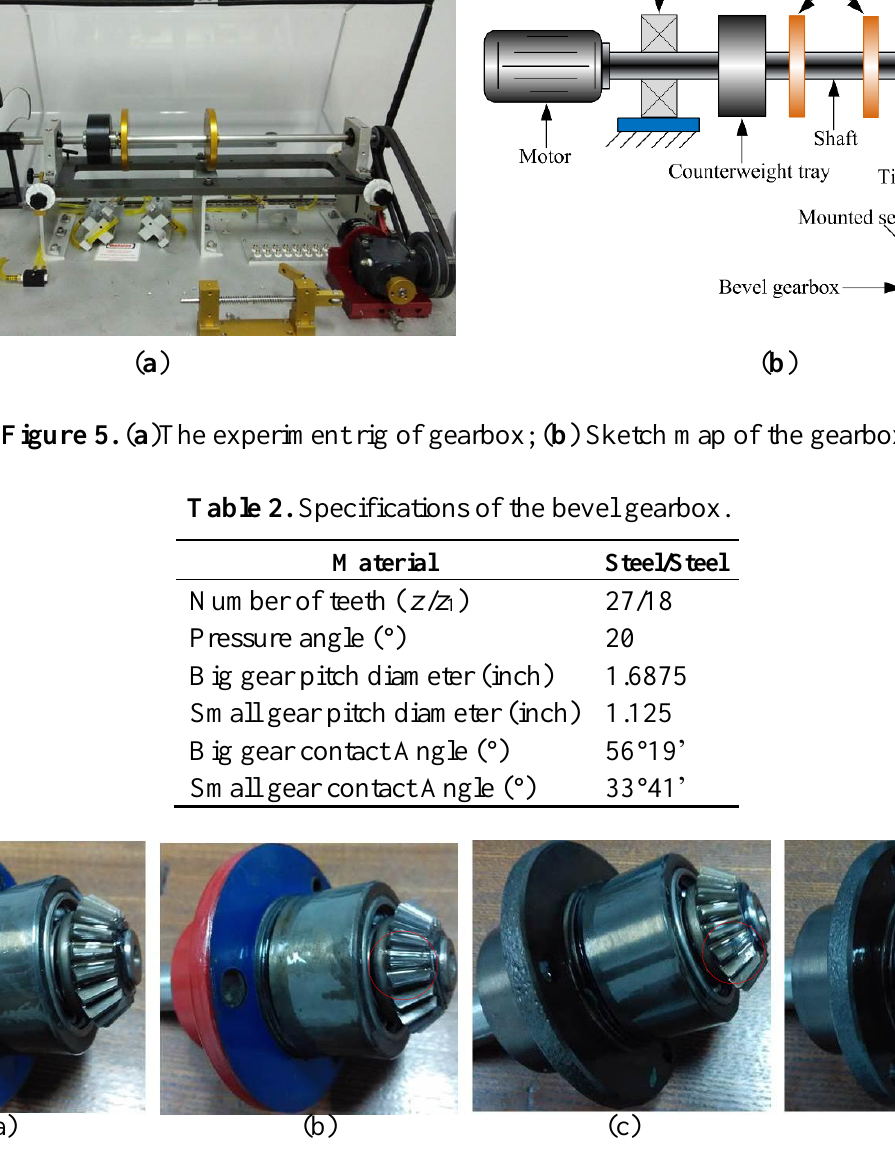
Figure 6. The three bevel gears with different damages: ( a ) normal state; ( b ) worn tooth; ( c ) broken tooth; ( d ) missing